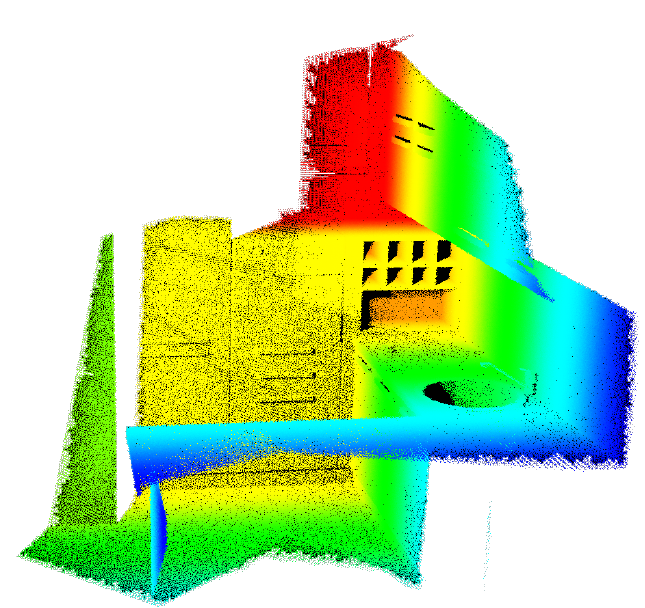
Figure 17. Original reference data extracted from the BlenSor database—kitchen model. Figure 17 . Original reference data extracted from the BlendSor database — kitchen model.